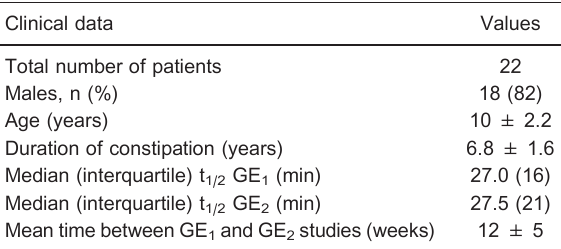
Table 1. Clinical data of 22 constipated patients and scinti- graphic t 1/2 gastric emptying values, before impaction removal (GE 1 ) and after recovery from constipation (GE 2 ).